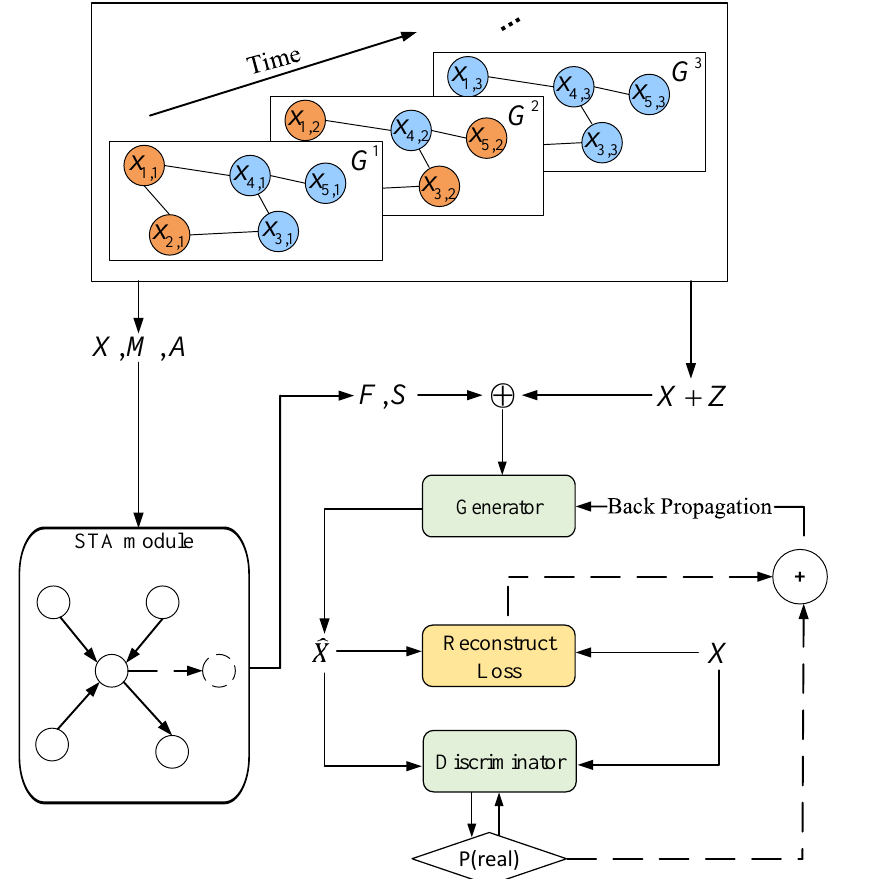
Figure 6. The architecture of the STA-GAN model, where ⊕ denotes the concatenation operator, and + indicates the addition of two